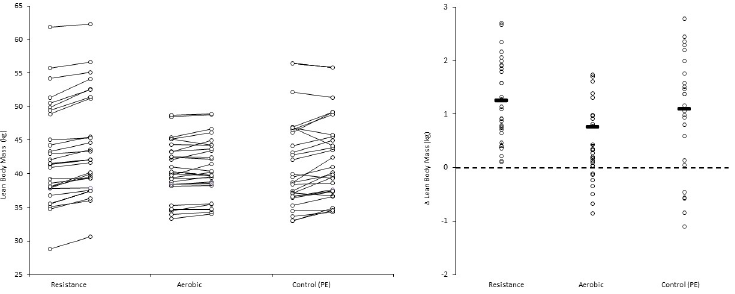
Fig 1. Left panel: Lean body mass values (kg) pre- and post- intervention for each participant, and group means. Right panel: Individual participant and mean within-group post-intervention lean body mass difference (kg). Pairwise effect sizes for within-group difference in lean body mass: Resistance; d = 0.18, aerobic; d = 0.15, PE (control); d = 0.17.